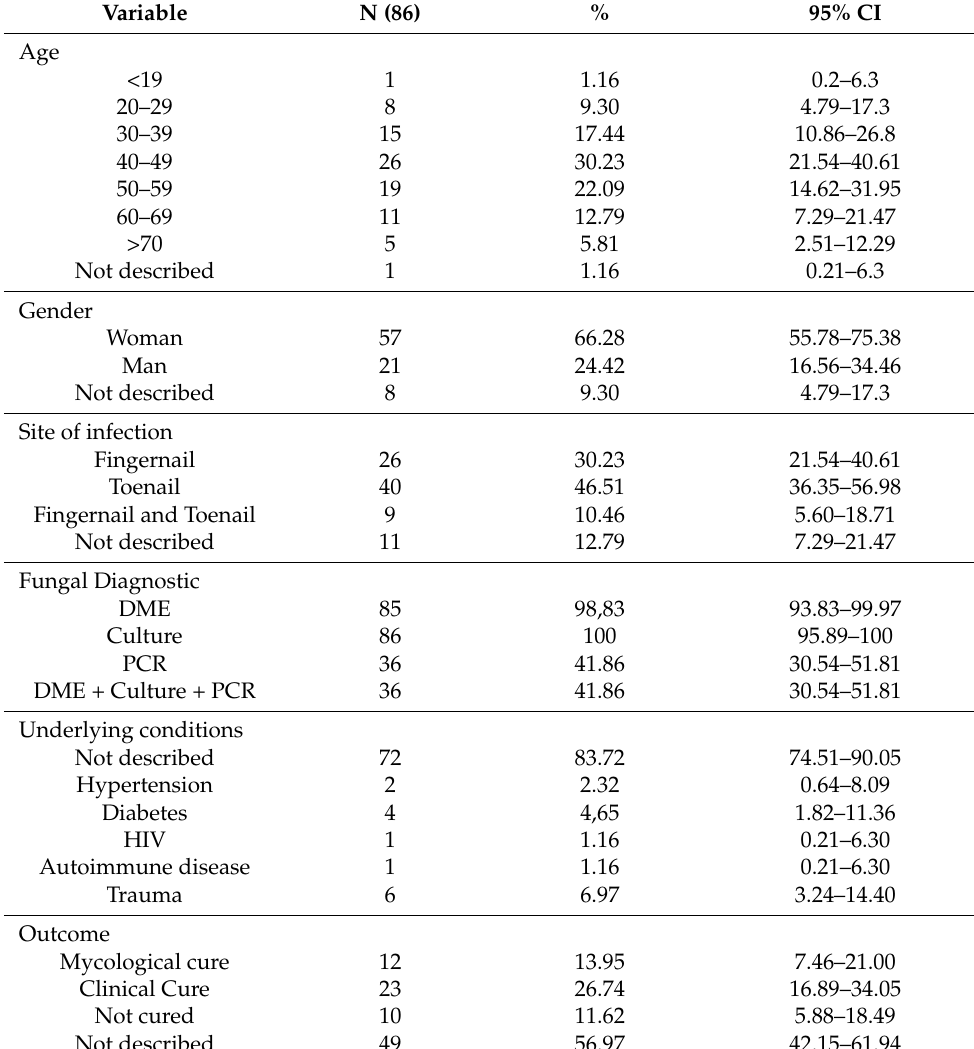
Table 1. Demographic and clinical characteristics of 86 cases of Fusarium onychomycosis.